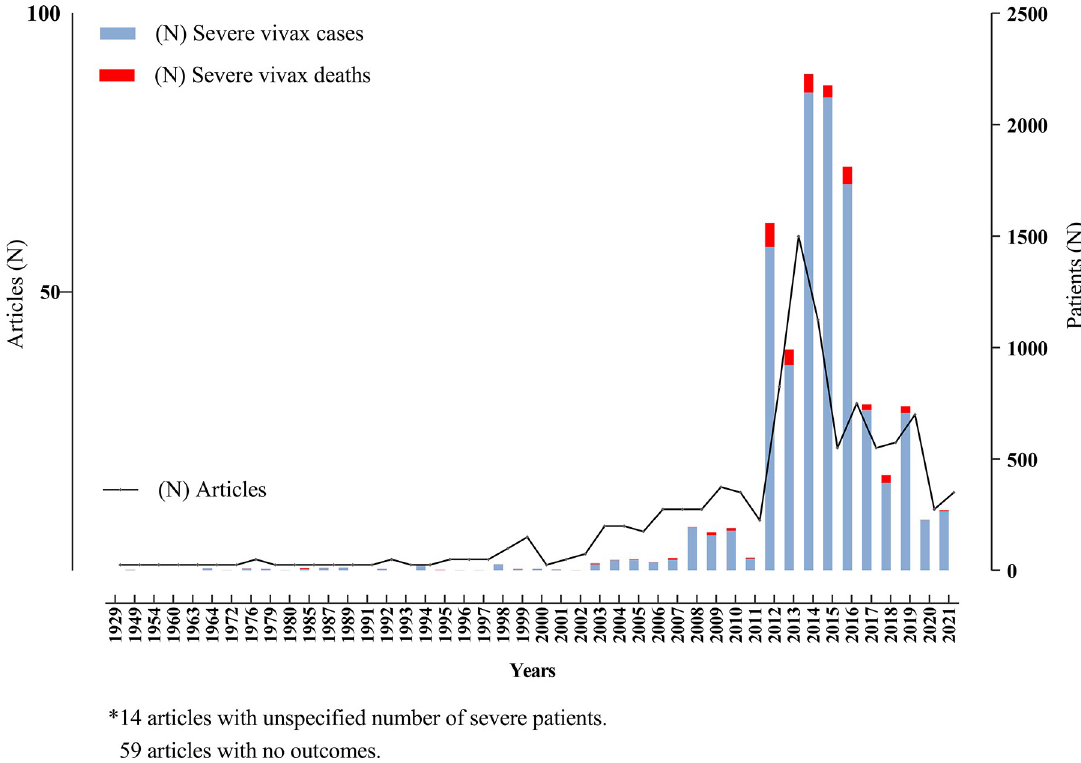
Fig 1. Summary of severe vivax patients, number of deaths reported, and articles by year (1928 to 2020).